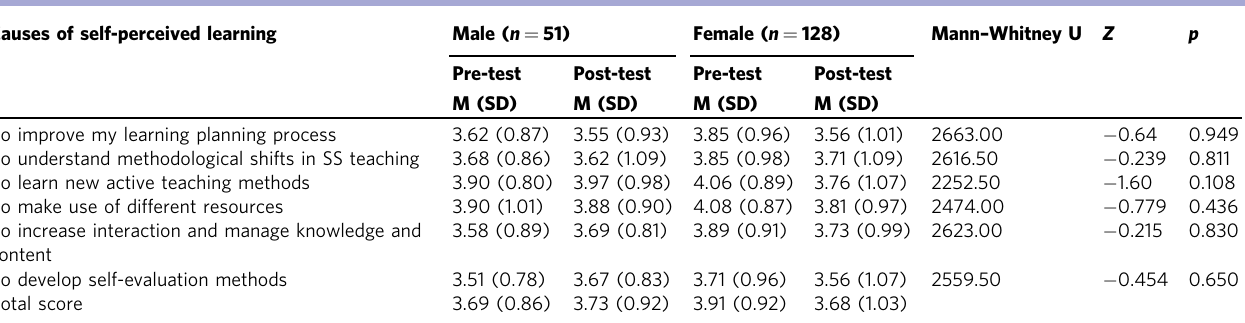
Table 5 Descriptive statistics for the variables referring to self-perceived learning in this approach during the COVID-19 pandemic according to the gender of the